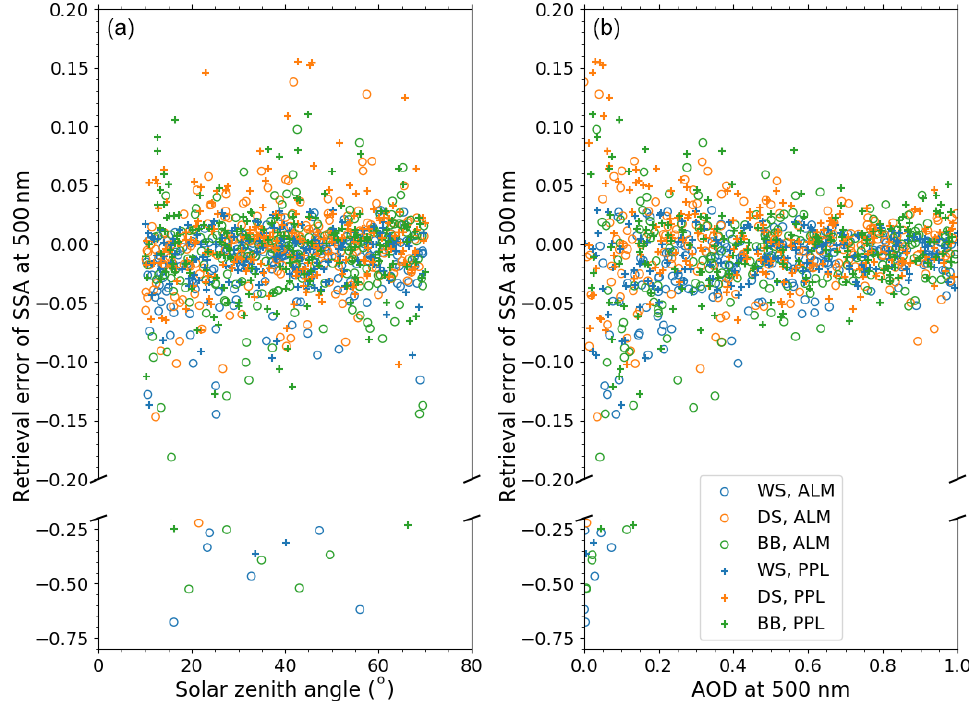
Figure 1. Dependencies of the retrieval errors of the single-scattering albedo at 500nm on the solar zenith angle (a) and the aerosol optical depth at 500nm (b) . WS, DS, and BB denote the water-soluble (blue), dust (orange), and biomass burning (green) models, respectively. ALM and PPL denote the scanning patterns of the almucantar (circle) and principal plane (plus) geometries, respectively.